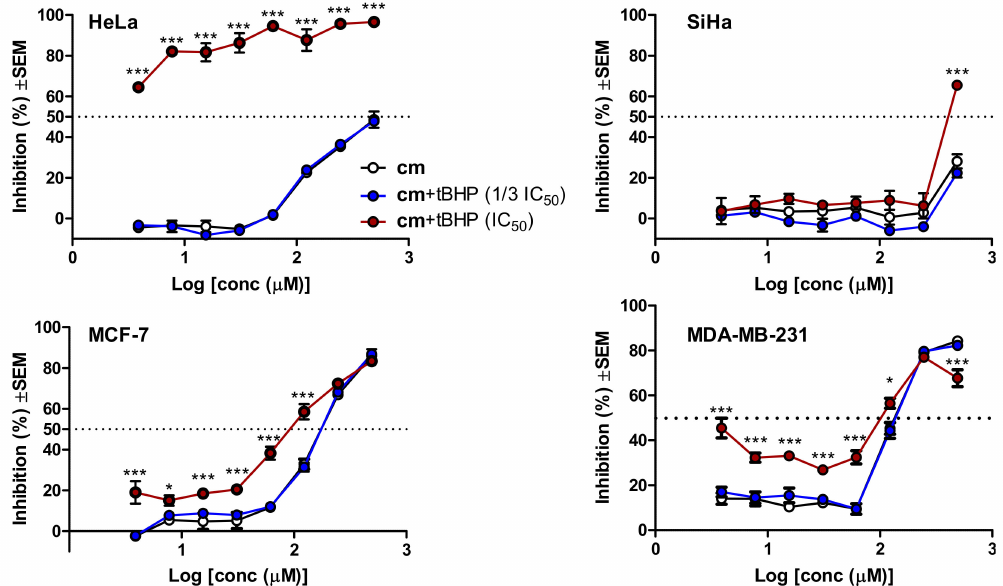
Figure 5. Cytotoxic activity of methyl ca ff eate ( cm ) on gynecological cancer cells with or without tert -butyl hydroperoxide ( t -BHP)-induced intracellular oxidative stress. Cells were pre-treated with t -BHP for 24 h at its 1 / 3 IC 50 or IC 50 concentration that was previously determined in a 72 h MTT assay, then the medium was removed, the cells were washed with PBS, and cm treatment was performed for 72 h in freshly added media. Results were analyzed by two-way ANOVA followed by a Bonferroni post-hoc test, * and ***: p < 0.05 and p < 0.001, respectively, as compared to the single treatment with cm ; n =